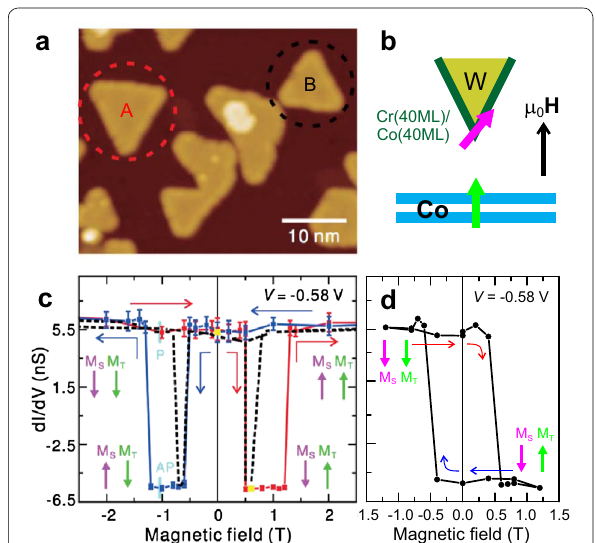
Fig. 5 d I/ d V hysteresis loops of Co islands measured with a ferro‑ magnetic tip. a CC‑STM image of Co islands on Cu(111) ( V b I set 1 nA). b Schematic illustration for the spin‑STM measurements = shown in c and d . Note the tip material configuration. c , d I/ d V hysteresis loops at the center of the Co islands A and B marked by the red and black dashed circles , respectively, in a . The red ( blue ) color is for the measurements on the island A and corresponds to forward ( back- ward ) sweep of the magnetic field. The black dashed line presents a d I/ d V hysteresis loop of the island B in a . d , Minor hysteresis loop taken at the center of island A, with the sample magnetization M S pointing down as indicated (Reprinted from [4] with permission from American Physical Society (Copyright